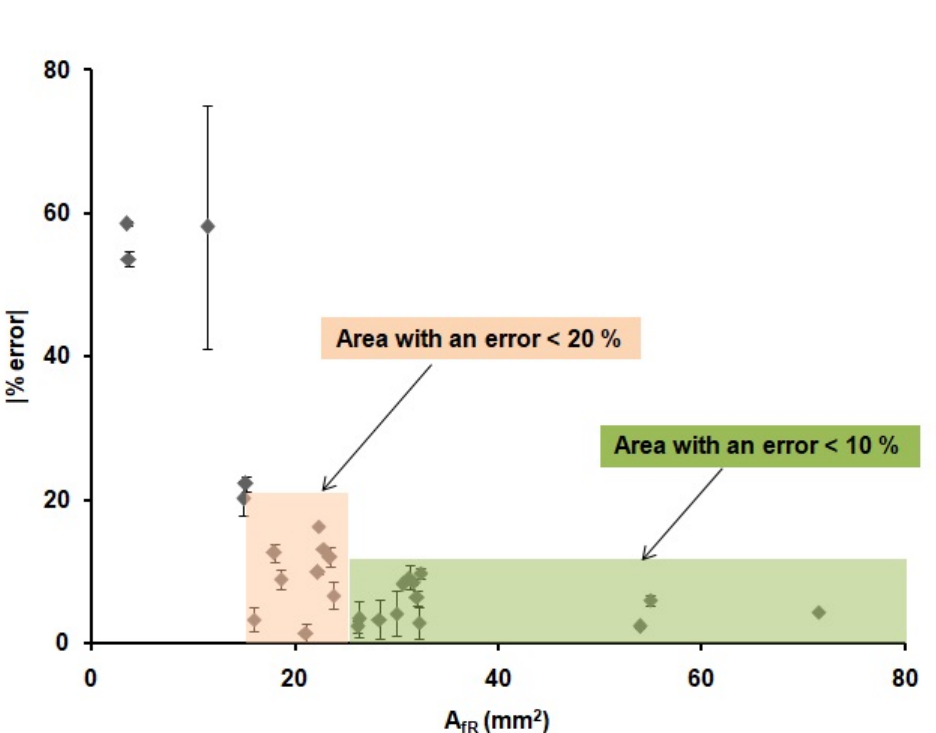
Figure 5. Absolute value of the relative error (%) of the real internal areas ( A fR ) of the 26 µPADs for different device configurations obtained when using the equation from Figure 4.